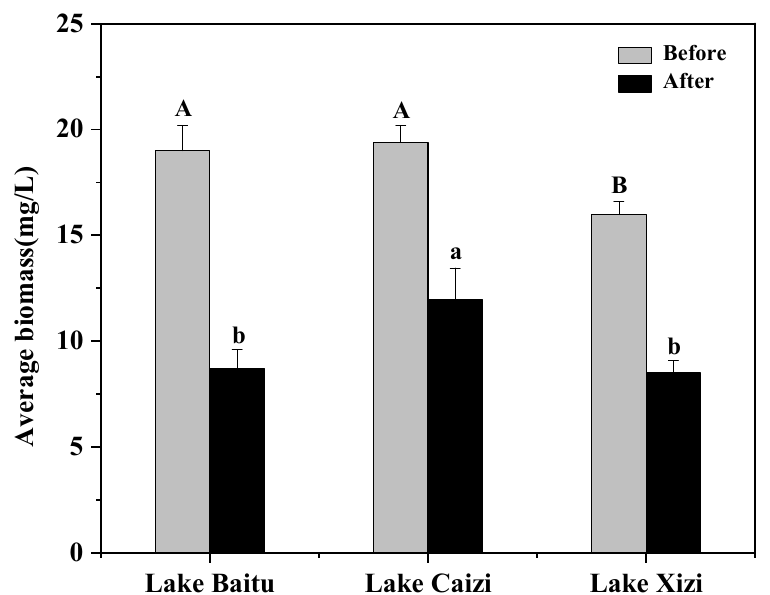
Figure 7. Spatial variation of the phytoplankton biomass before and after the aquatic vegetation restoration. Upper case letters indicate significant differences between lakes before restoration, lower case letters indicate significant differences between lakes after restoration. The comparison between upper- and lower-case letters for each lake indicated significant differences before and after restoration. The same letter indicated a non-significant difference ( p > 0.05), different letters indicated a significant difference ( p < 0.05).